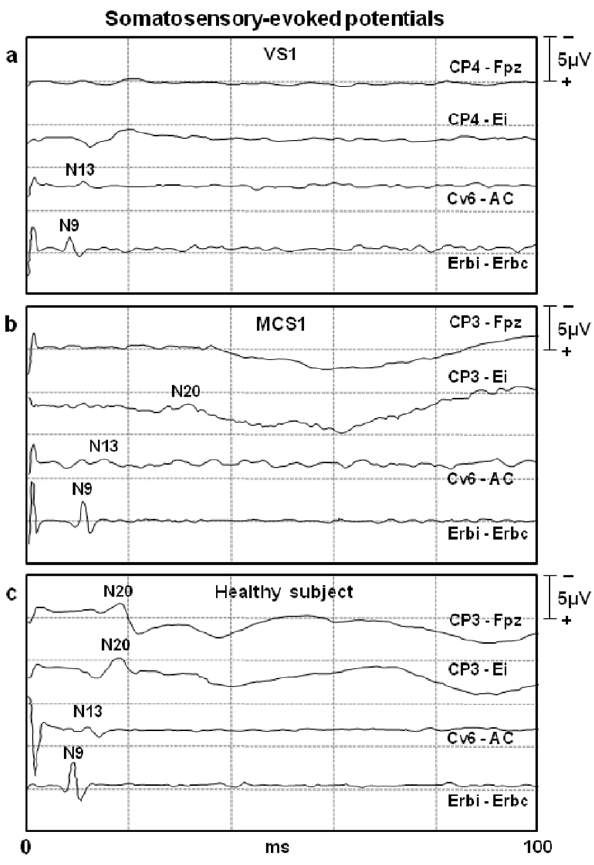
Figure 3. Representative short-latency median nerve somato- sensory-evoked potential (SEPs) tracings in one VS1 (a) patient, one MCS1 (b) patient, and one normal (c) subject. In the VS patient, the electrical stimulation at the wrist elicited the activation of the brachial plexus at Erb’s point (wave N9) and of the cervical spine (wave N13) with normal amplitude/latency characteristics. Even the subcortical far-field P14 wave was recordable, while no cortical activation was detectable (i.e., absence of N20 wave) in the contralateral somatosensory cortex of the VS1 patient. In patient MCS1, the SEPs were abnormal, as the cortical component N20 was delayed and of a very small amplitude ( , 0.7 m V) and was only detected with the earlobe- reference montage. CP3/CP4: parietal scalp electrodes contralateral to stimulation; Fz: reference mid-frontal scalp electrode; Ei: reference electrode on the earlobe ipsilateral to stimulation; Cv6: posterior spinal cervical electrode over the 6th cervical spinous process; AC: anterior neck reference electrode; Erbi/Erbc: clavicle Erb’s point electrodes, ipsilateral or contralateral to stimulation.